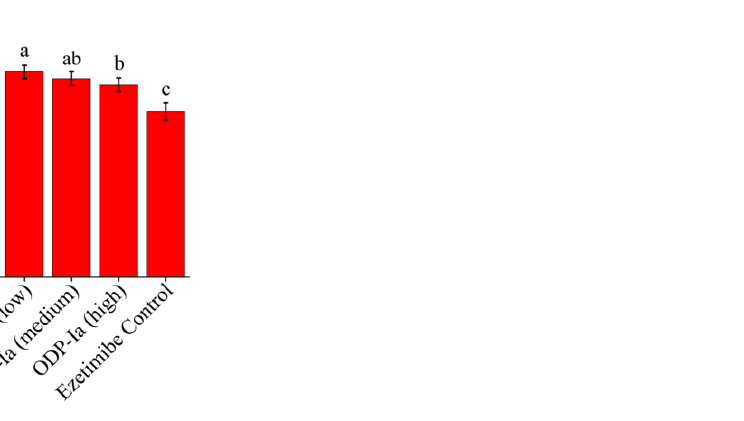
Figure 4. Effects of ODP-Ia on the cholesterol outflow in foam cells. (mean ± SD, n = 5). Different superscript letters indicate multiple comparisons with significant differences (SNK-q test, p < 0.05).